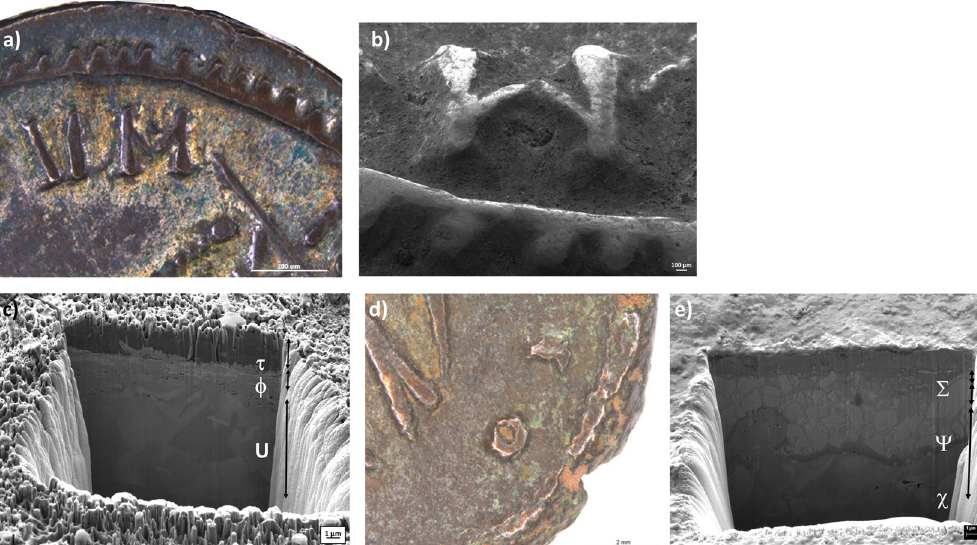
Figure 6. Optical microscopy (OM) photograph of Sev1 highlight golden areas on the surface ( a ). Secondary electron image of a trench performed with FIB-FESEM in the same area is shown in figure ( b ) and then the trench shows the porous morphology of Hg-Ag amalgam on the coin surface in ( c ). Optical ( d ) and secondary electron images of the trench performed with FIB-FESEM in the same area of figure ( e ) of Cla312. The trench shows the Pb square structure in the ψ analyzed area. Trench image width 18.5 μ